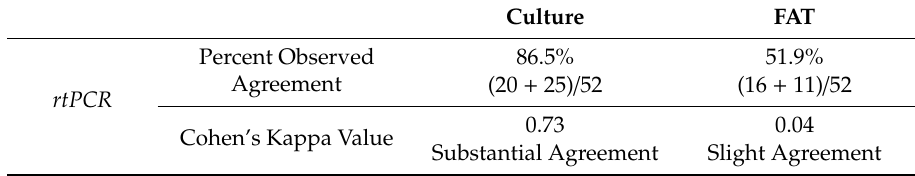
Table 1. Percent observed agreement and Cohen’s Kappa evaluation of the rtPCR method of detection compared to previously reported culture and FAT detection techniques. Reported values were calculated including both positive and negative testing (total of 52